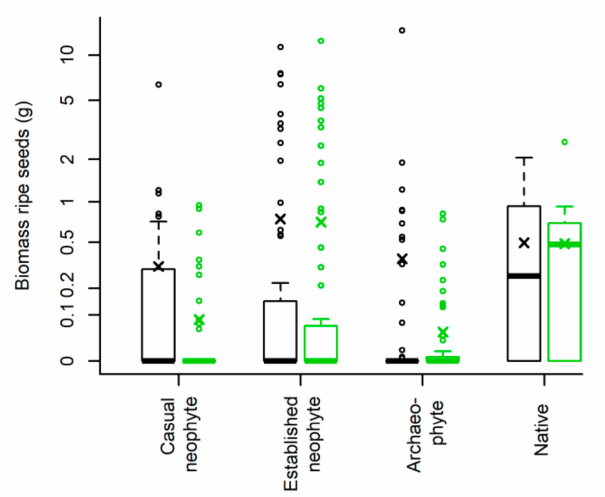
Figure 2. Ripe seeds biomass depending on invasion status for the 42 Asteraceae species (397 individuals). Treatment “with pollinators” in black, treatment “without pollinators” in green. The boxplots show the median per group (solid line), crosses the mean, the boxes represent the 25th and 75th quantile, whiskers the normal data range and circles the outliers. Axis is shown on a